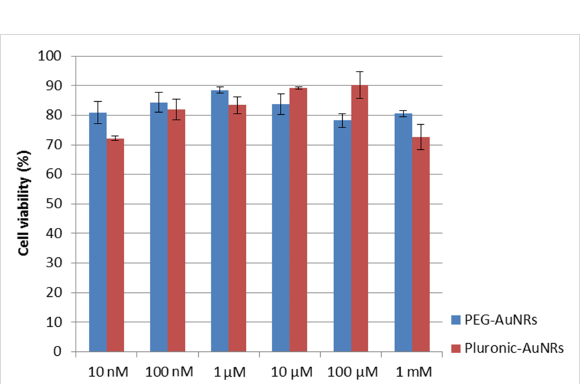
Figure 4: Cell viability of AuNRs encapsulated with different concen- trations of PEG-SH or Pluronic triblock copolymer. The concentration of PEG-SH and Pluronic adopted for encapsulation ranges from 10 nM to 1